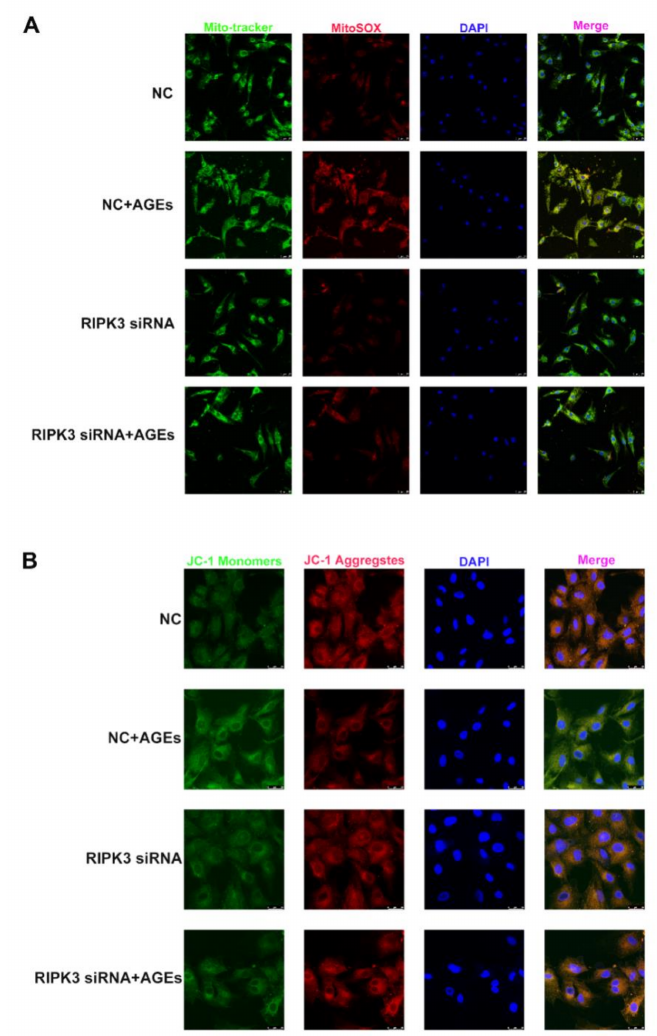
Figure 10. Down regulation of RIPK3 reduced oxidative stress in cardiomyocytes. Cardiomyocytes were transfected with RIPK3 siRNA for 4 h followed by 200 µ g/mL AGEs stimulation for 24 h. ( A ) The generation of superoxide anion reactive oxygen species in mitochondria was detected by MitoSOX (Red) staining. Mito-Tracker (Green) co-localized mitochondria. The nuclei were stained by DAPI (Blue). Bar = 25 µ m. ( B ) Mitochondrial membrane potential was detected by JC-1staining. When it is high, JC-1 aggregates in the matrix (Red). When it is low, JC-1 is mainly monomers (Green). The nuclei were stained by DAPI (Blue). Bar = 25 µ